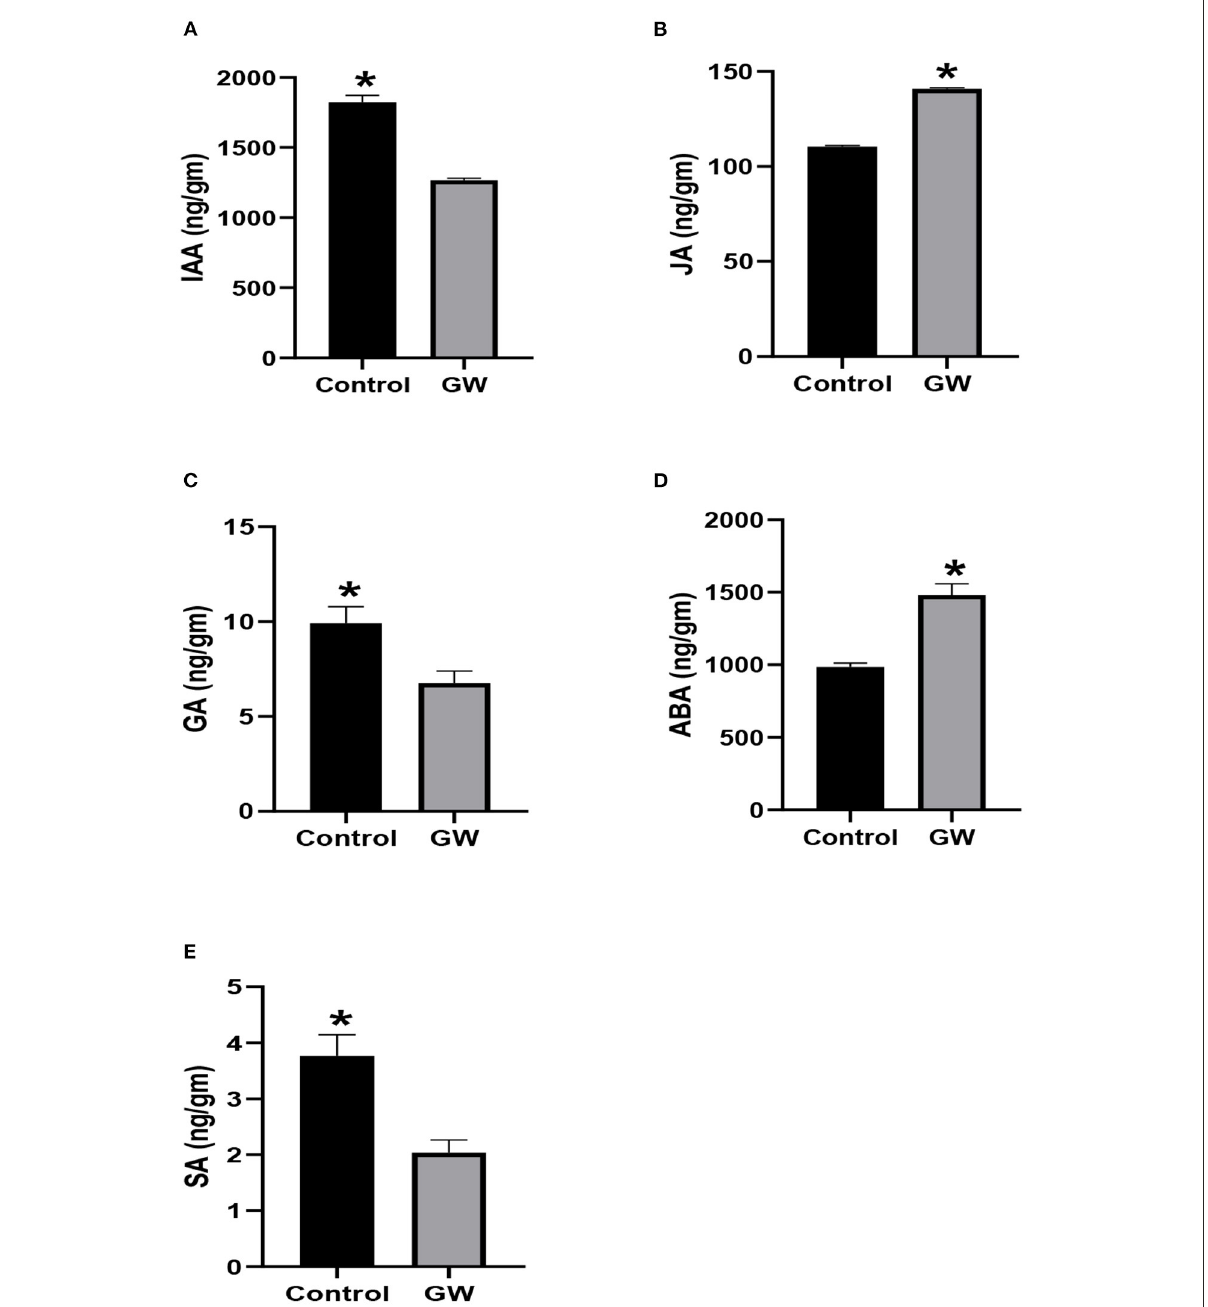
FIGURE7 Determination of different phytohormones (A) IAA, (B) JA, (C) GA, (D) ABA, and (E) SA in Avena fatua inoculated with the endophytic fungus Fusarium oxysporum GW. The seedlings were grown for 21 days inautoclaved soil inoculated with fungal biomass. Bars show the mean of three replicates with standard deviation. Bars labeled with * are significantly higher ( t -test; p <